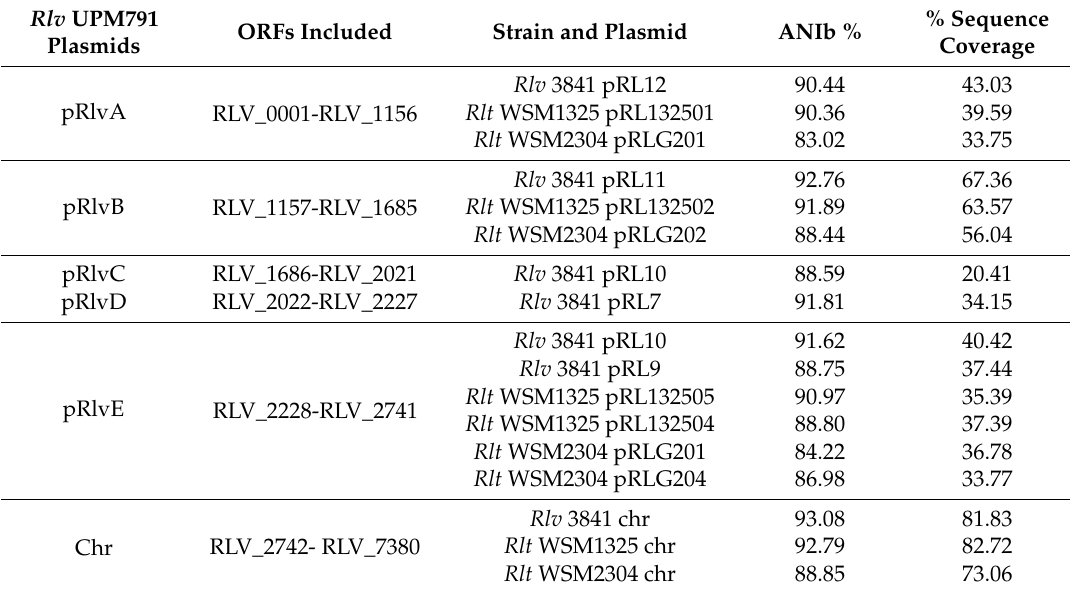
Table 2. Average Nucleotide Identity based on BLAST algorithm (ANIb) for Rlv UPM791 replicons as compared to other Rl